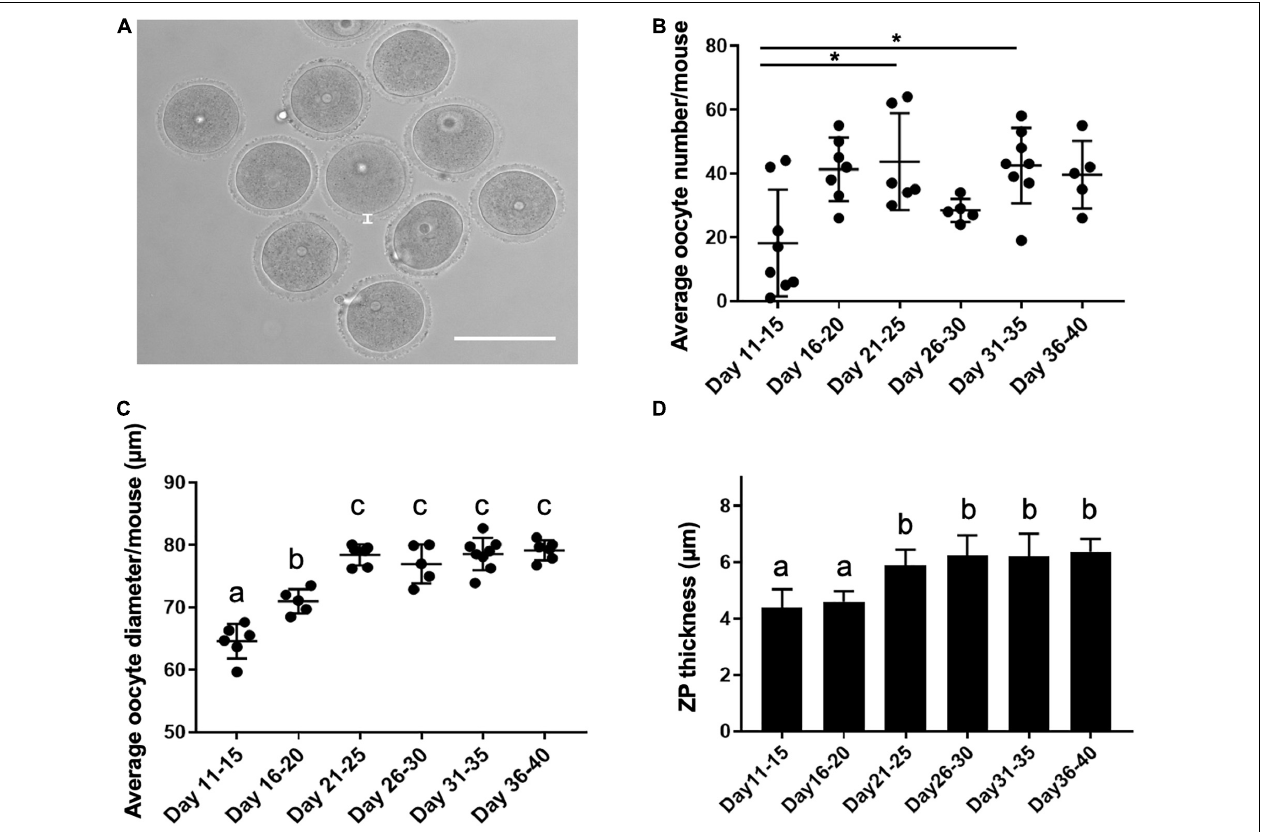
FIGURE 2 | Oocyte characteristics during the pubertal transition as assessed by yield, diameter, and zona pellucida thickness. (A) A representative transmitted light image of oocytes isolated from antral follicles. The thickness of the zona pellucida (ZP) is delineated by the white line. The scale bar is 100 µ m. (B) The average number of oocytes collected per mouse in each age cohort was examined ( n = 36 mice, 5–8 mice per age cohort). Asterisks denote groups significantly different from each other ( p < 0.01). (C) The average oocyte diameter was calculated for oocytes collected from each mouse in distinct age cohorts ( n = 363 oocytes, 36 mice, 4–8 mice per age cohort). Groups with different letterheads are significantly different from each other ( p < 0.01). (D) Zona pellucida thickness was measured for a total of 113 oocytes from 7 to 15 mice per age cohort, and the average values are plotted. Error bars represent standard deviation (SD). Column bars with different letterheads are significantly different from each other ( p <